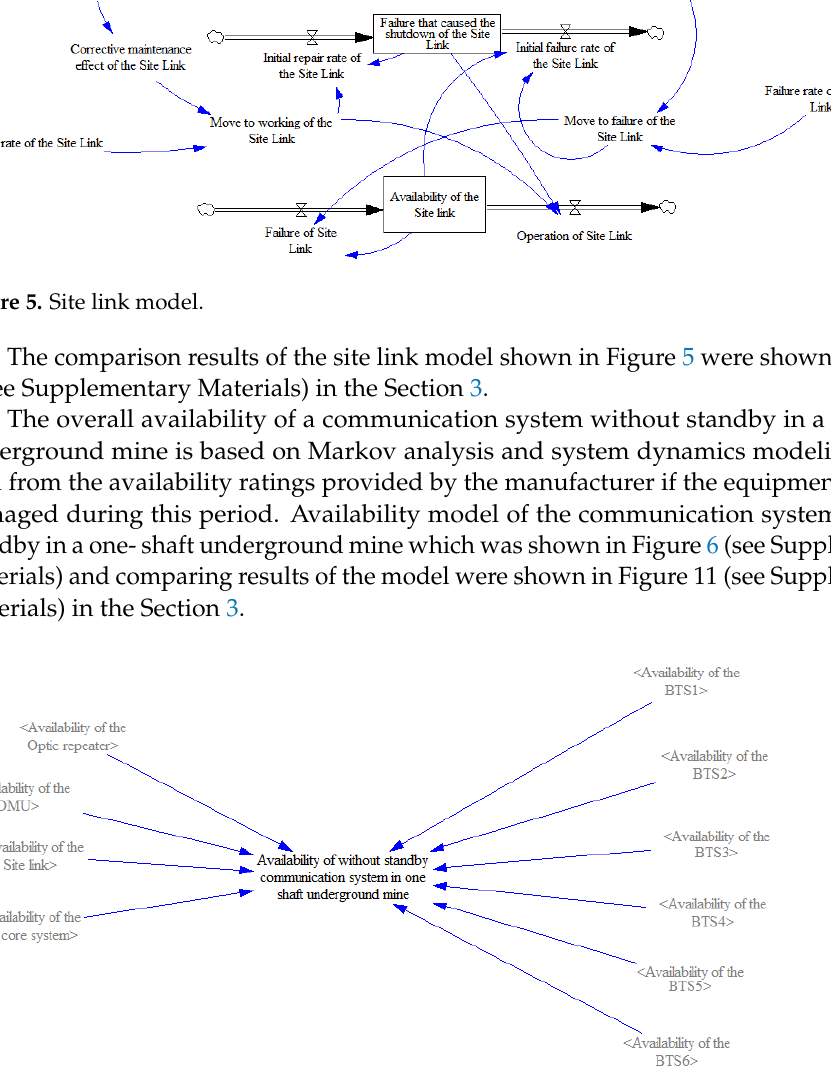
Figure 6. Availability of a communication system without standby in a one-shaft underground mine.